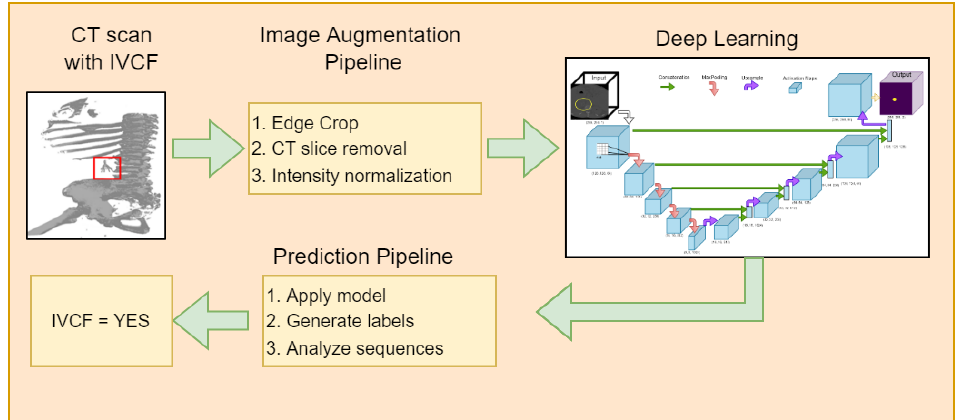
Figure 1. Schematic diagram of the proposed approach to IVCF detection.